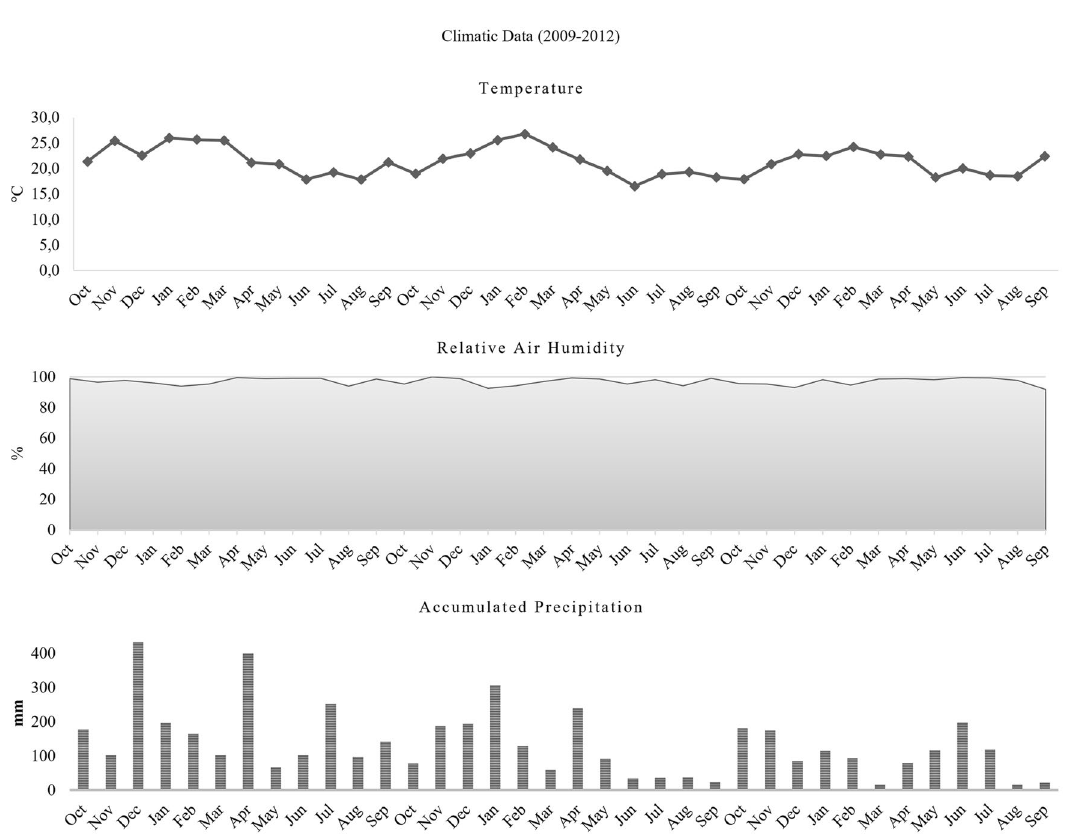
Figure 2. Climatic data from the National Institute of Meteorology of Temperature (°C), Relative Air Humidity (%) and Accumulated Precipitation, from October 2009 to September 2012, Municipality of Paraty, State of Rio de Janeiro,